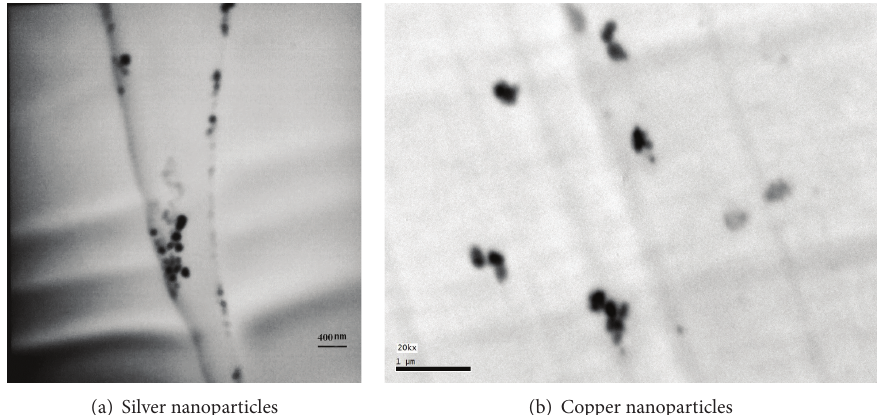
Figure 3: Transmission electron micrograph of cross-section fabric (a) after loading with nanosilver oxide and (b) after loading with nanocopper oxide.